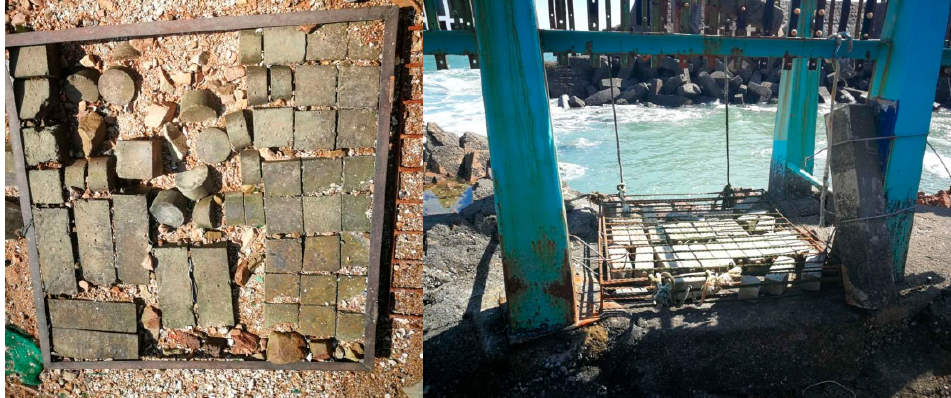
Figure 3. Architectural concrete exposed to actual marine environments.